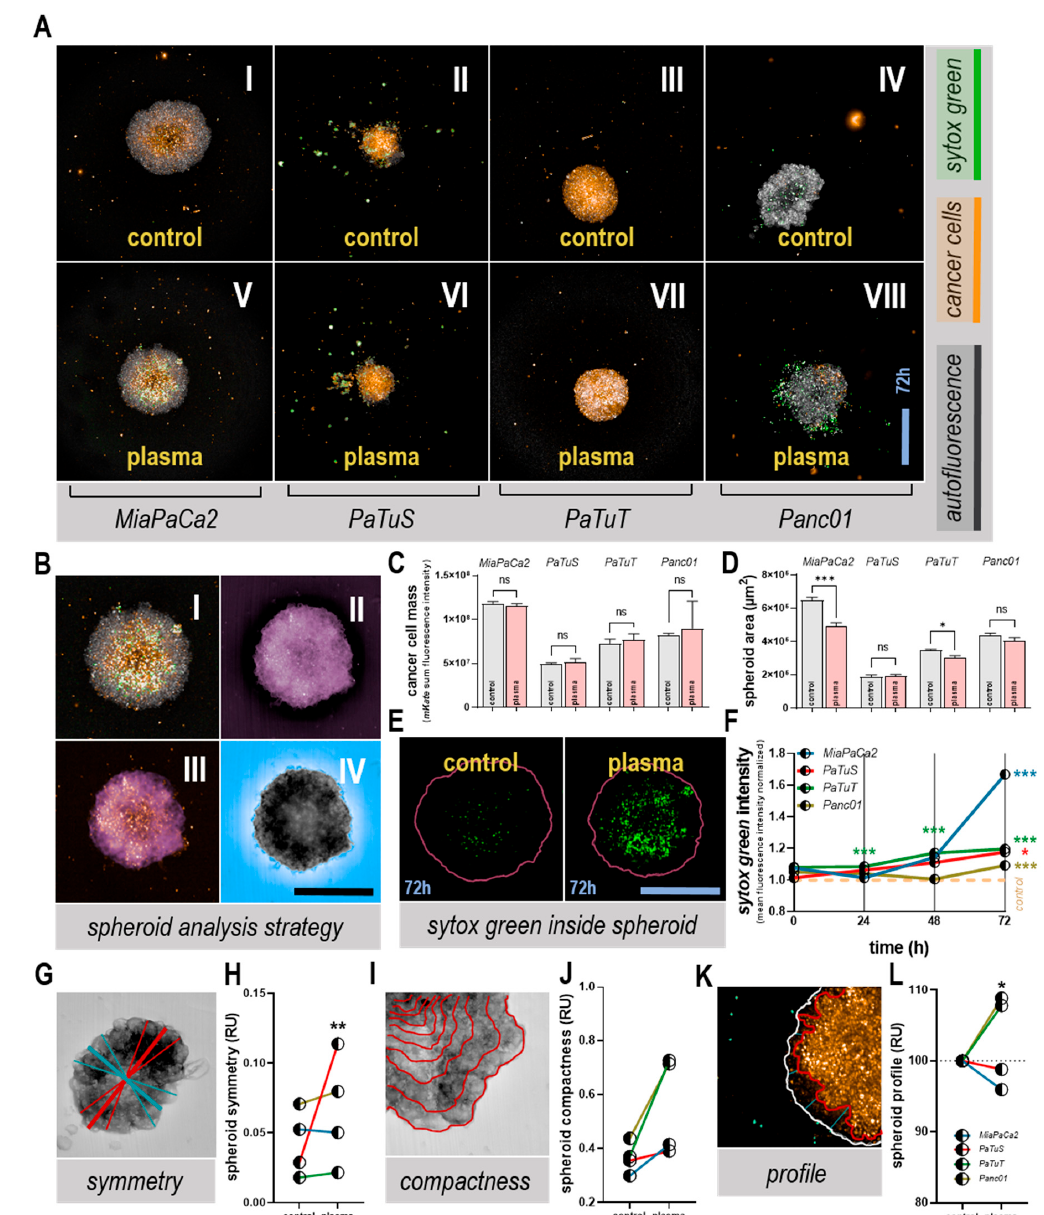
Figure 4. Plasma treatment altered tumor spheroid morphology and induced toxicity. ( A ) representative images of DiL-labeled tumor spheroids grown in Matrigel extracellular matrix stained with sytox green for life-dead cell discrimination 72h after exposure to plasma; ( B I ) representative merged image, ( B II ) calculated pseudo-color image of all channels, ( B III ) further processed image with intensity cut-off, and ( B IV ) spheroid-surrounding area segmented; ( C ) quantification of DiL intensity of spheroid immediately after treatment; ( D ) quantification of spheroid area segmented 72 h post plasma-treatment; ( E ) representative images of sytox green signal within the spheroid area (red line) and ( F ) their quantification during a 72 h time-course normalized on each cell line’s respective control; analysis of morphology parameters with representative scheme of ( G ) spheroid symmetry and ( H ) its quantification for all cell lines 72 h post-treatment, ( I ) spheroid compactness and ( J ) its quantification, and ( K ) spheroid profile and ( L ) its quantification. Data are mean + SEM ( C – D ) or mean ( F,H,J,L ) of three replicates per cell line and the group as representative of three independent experiments; ns = not significant. Scale bars represent 450 µ